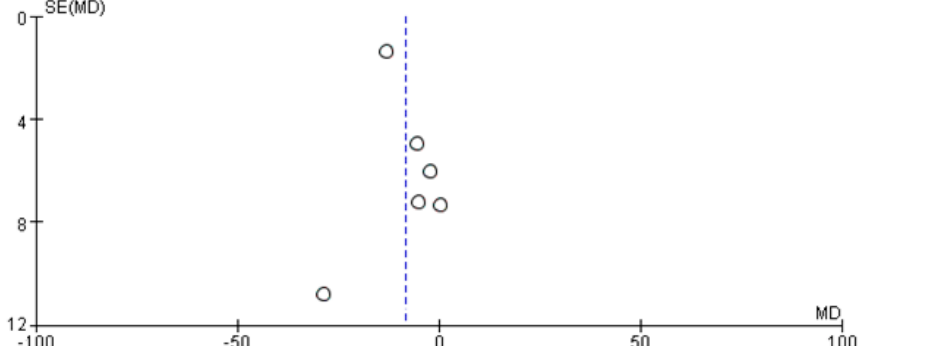
Figure 2. A forest plot showing the association between POR*28 carriers and standardized trough concentration (ng/mL per mg/kg) of tacrolimus.